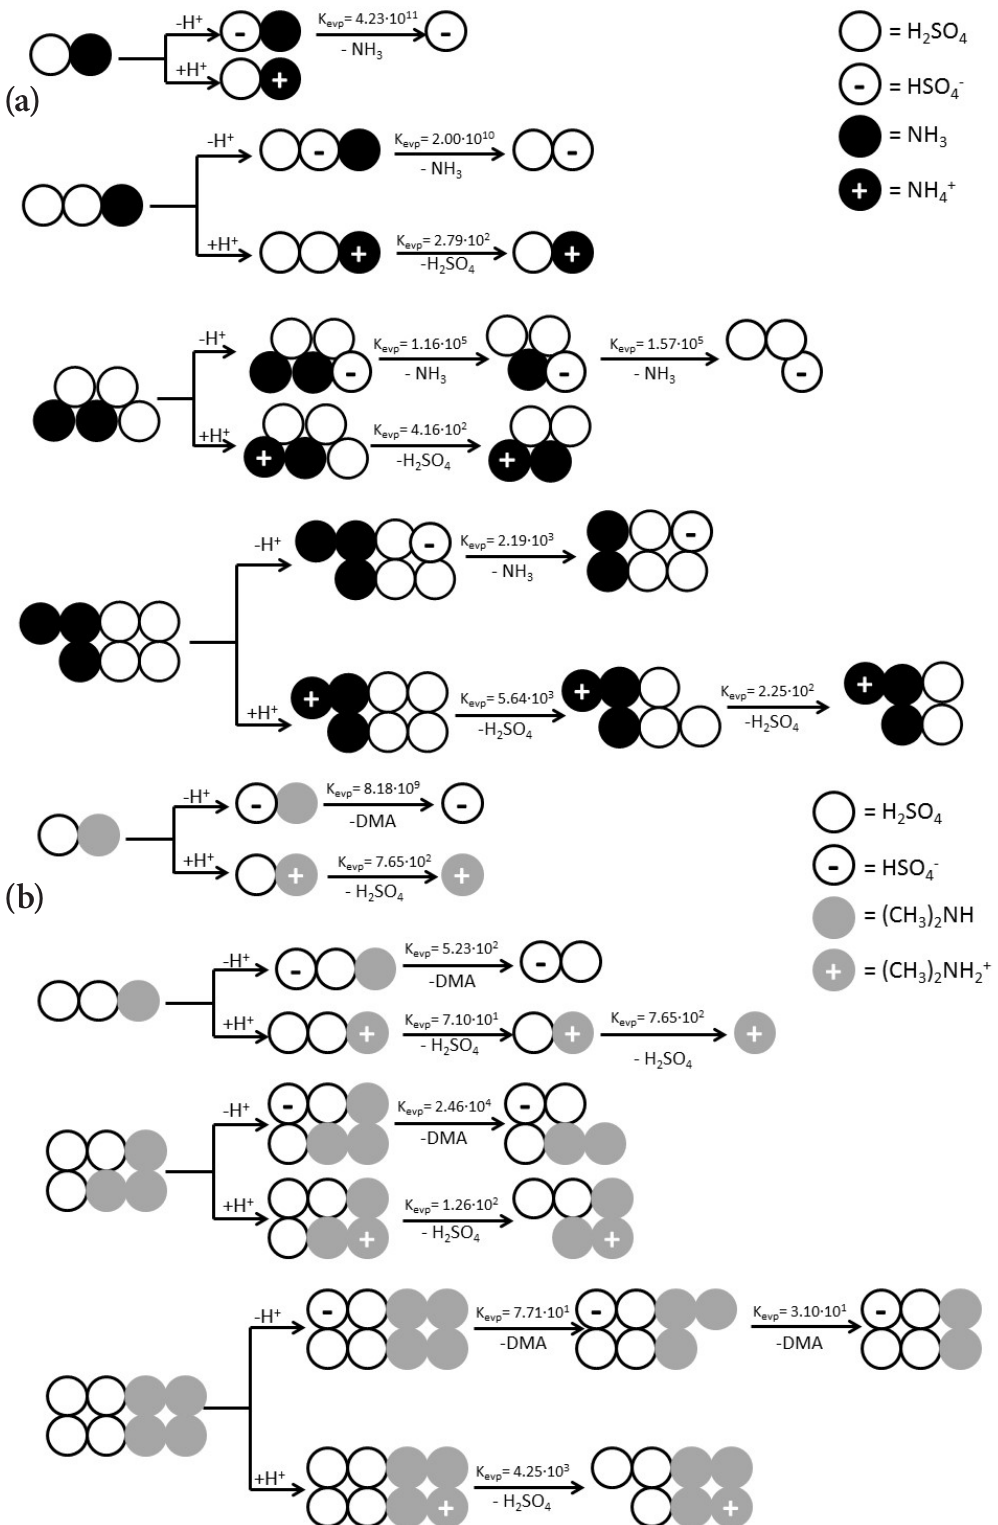
Figure 7. Schematic representation of the evaporation pathways after charging of the most stable neutral base-containing clusters. White circles represent sulfuric acid, white circles with a minus sign represent the bisulfate ion, black circles represent ammonia, black circles with a plus sing represent the ammonium ion, grey circles represent dimethylamine and grey circles with a plus sign represent the dimethylam- monium